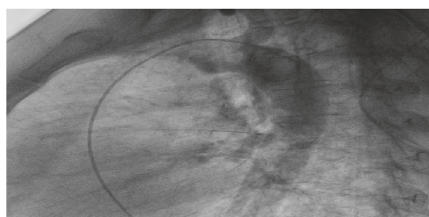
Figure 4: Aortic angiogram showing presence of a small PDA.